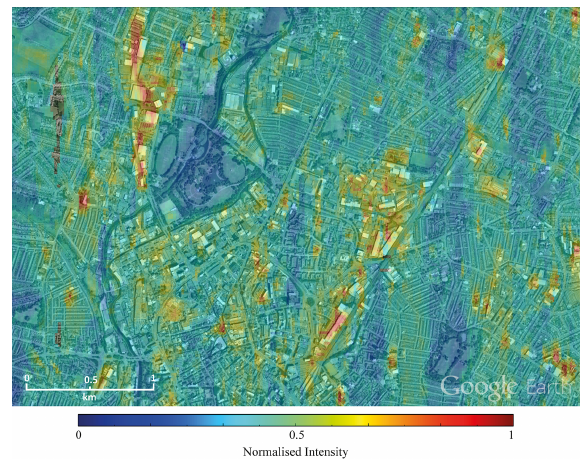
Figure 5. Google Earth overlay of the CompAQS 442.7nm forward interpolated intensity data showing co-location of bright industrial units and high intensity data recorded by